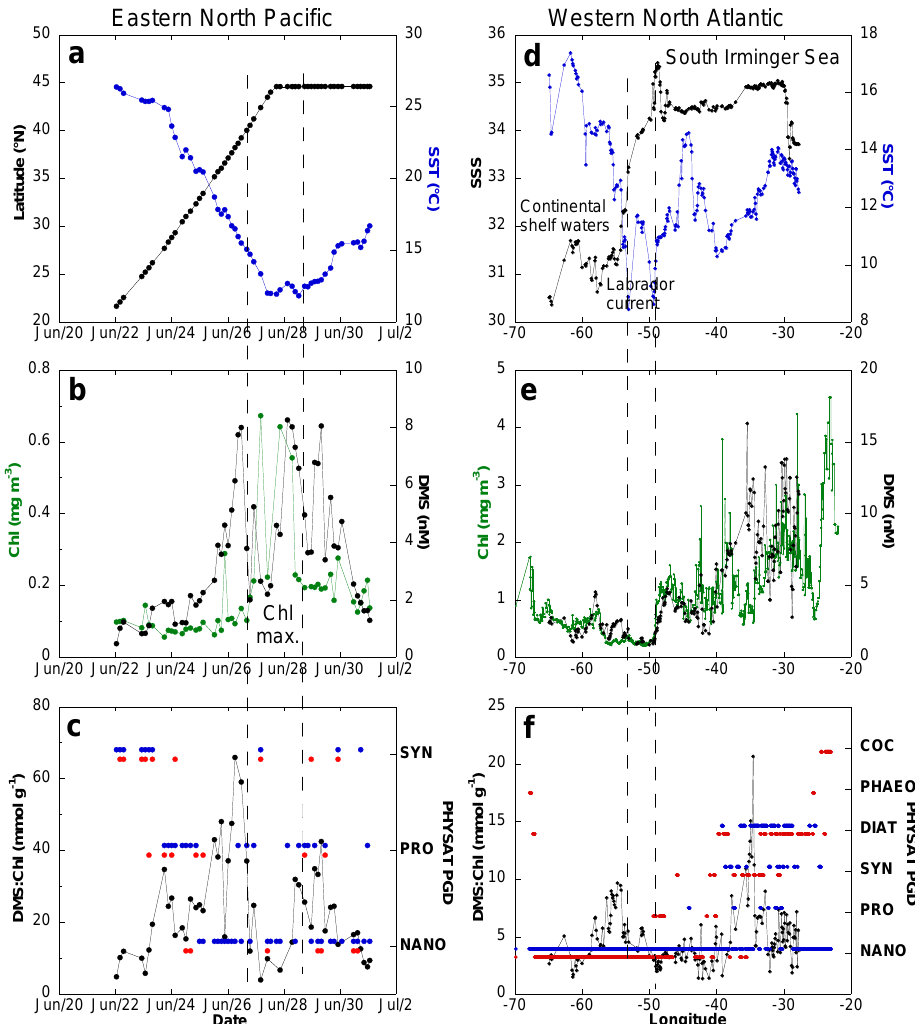
Fig. 8. Spatial or temporal distributions of the following parameters in the eastern North Pacific (left panels, cruise CN-169) and western North Atlantic (right panels, cruise CN-233): (a, d) sea surface temperature (SST: ◦ C, in blue), latitude (in black), and sea surface salinity (PSU, in black) (b, e) ocean color (Chl: mgm − 3 , in green) and sea surface dimethylsulfide concentration (DMS: nM, in black), (c, f) DMS- to-Chl ratio (DMS:Chl, mmolg − 1 , in black) and monthly (red dots) and monthly climatological (blue dots) composites of phytoplankton group